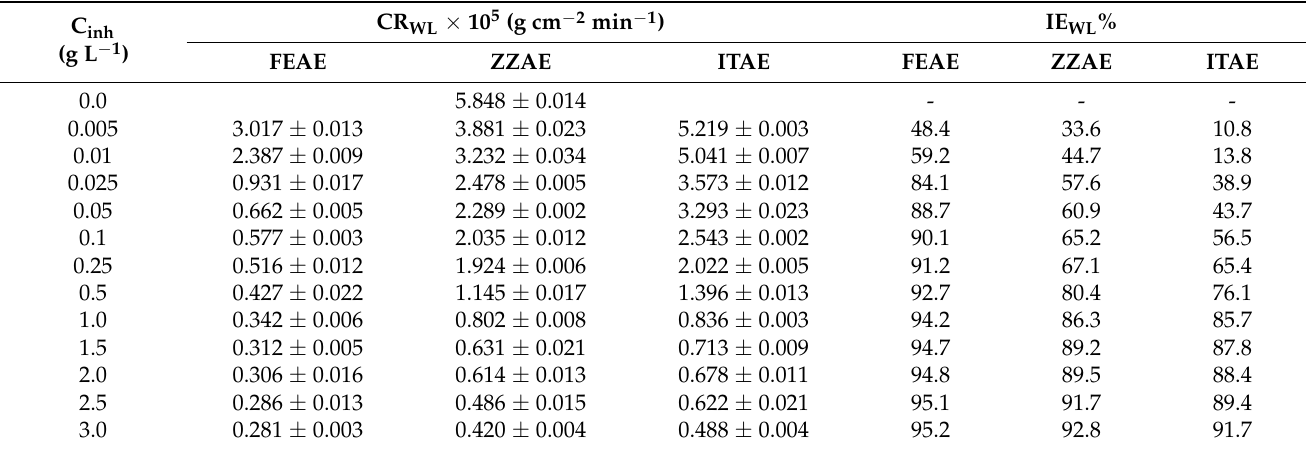
Table 2. Corrosion rates and inhibition efficiencies of mild steel corrosion in 2 M H 3 PO 4 solution with and without different concentrations of the studied plant